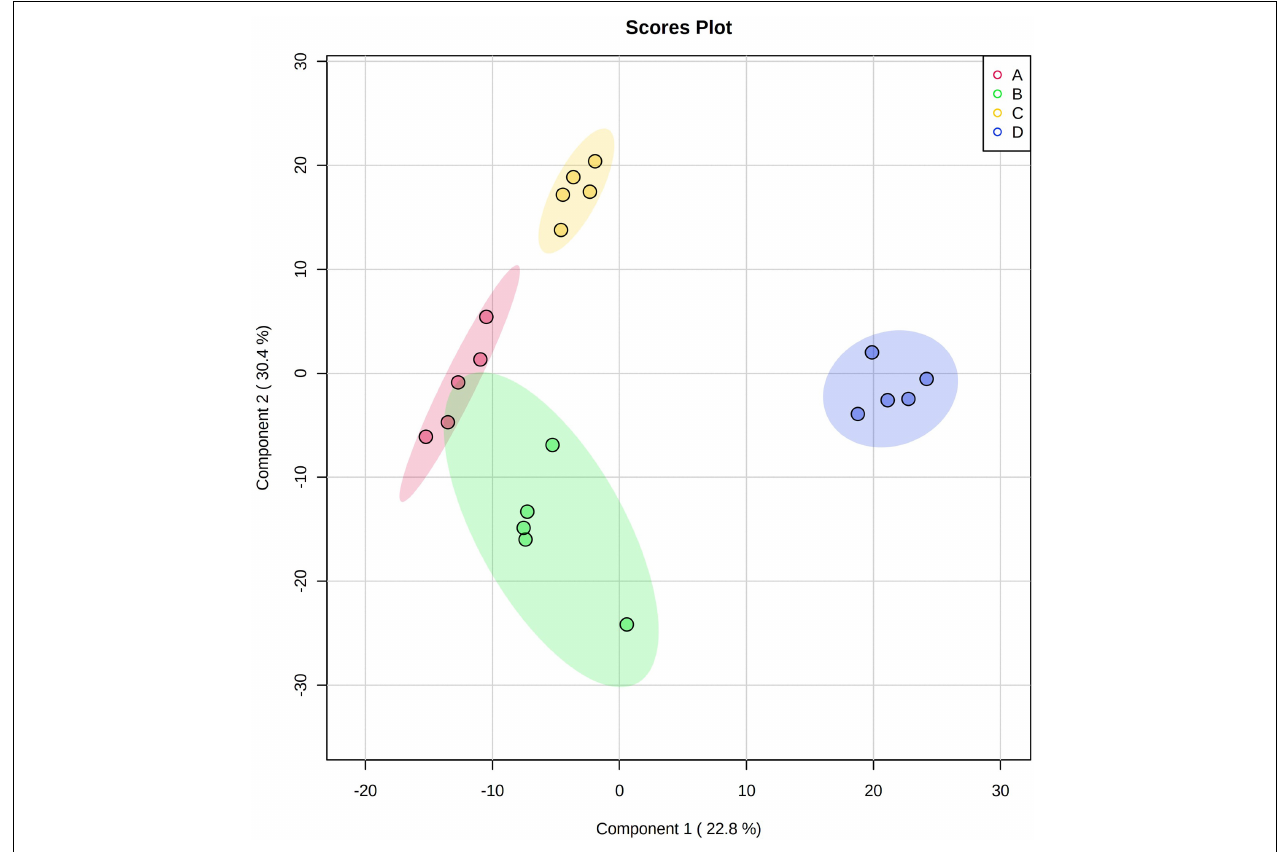
FIGURE 3 | Partial least squares discriminant analysis of metabolic profiles in roots of two maize varieties. Huidan No. 4 lead-free treatment (A) , Huidan No. 4 exposed to lead (B) , Ludan No. 8 lead-free treatment (C) , and Ludan No. 8 exposed to lead (D)